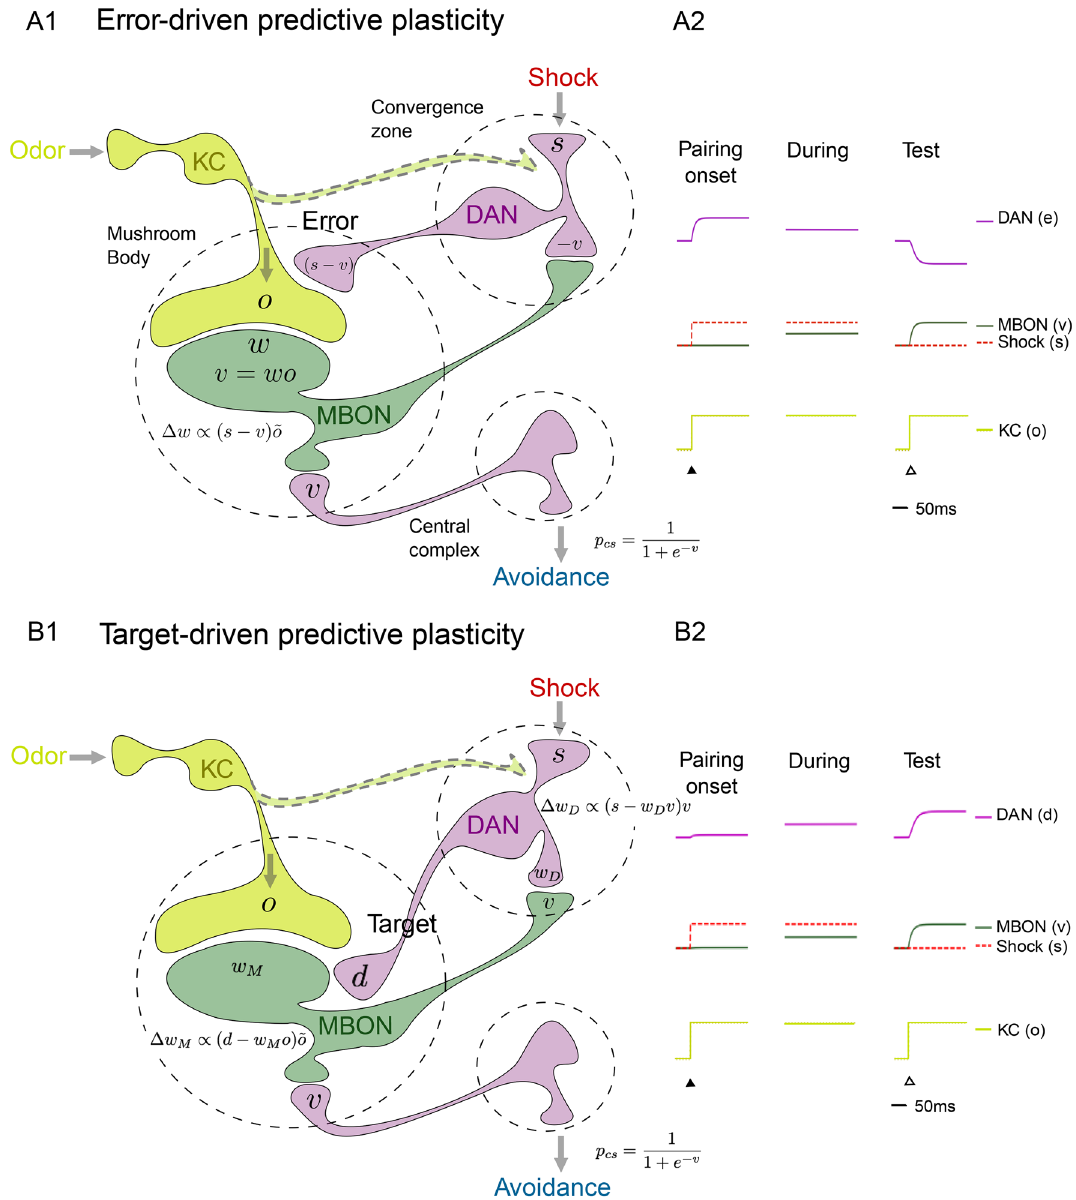
Figure 6. Suggested implementation of error- and target-driven predictive plasticity. (A1) Mushroom body circuits for olfactory error-driven predictive plasticity. Kenyon cells (KCs) carrying the odor information project to mushroom body output neurons (MBONs) through synapses encoding the aversive value ( v ) of the odor. The input triggered by the electroshock, s , drives the dopaminergic neurons (DANs) that are also inhibited by the MBONs. The DANs represent the prediction error, e = s − v , and modulate the KC-to-MBON synapses according to ˙ w ∝ e ˜ o , with ˜ o representing the odor eligibility trace. The conditioned response probability ( p cs , avoidance reaction) is a function of v . (A2) Neuronal activity traces of a DAN ( e , magenta), a KC ( o , light green) and a MBON ( v , dark green), shown at the onset of an odor-shock pairing (‘Pairing onset’, full triangle), 20 s later (During), and later at the test when only the odor is presented (‘Test’, open triangle, cf. Eq. 9). The aversive value v steadily increases (dark green), while the prediction error, e , decreases throughout learning and becomes negative when the odor is presented alone (purple). (B1) Mushroom body circuit for target-driven predictive plasticity. Beside the shock stimulus, the DANs can also indirectly be excited by the MBONs (or directly by the KC, not shown) to form a shock prediction also in the DANs and prevent fast extinction. The shock stimulus ( s ) sets the target for the MBON-to-DAN plasticity, and the DANs ( d ) set the target for the KC-to-MBON plasticity (cf. Eq. 11). (B2) As in A2 , but since the DANs now form a prediction of the shock itself based on v , their activity increases throughout learning, and they are also activated during the Test, when the conditioned odor is presented alone (Eq. 10). Sketch adapted from 33 and 6 that favor excitatory feedback to the DANs as in version